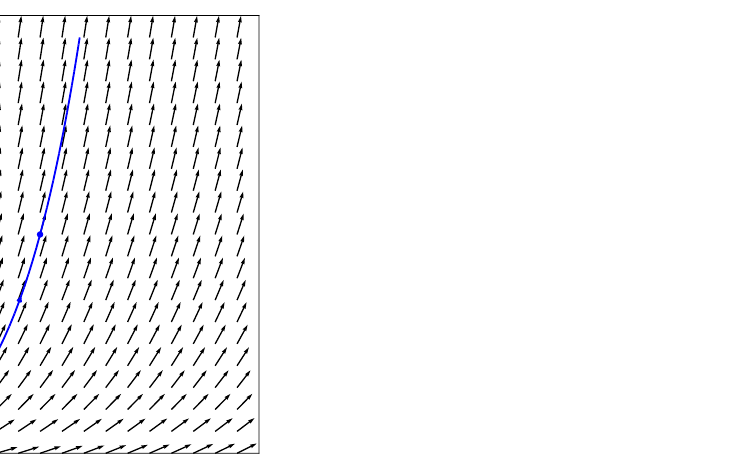
Figure 1. Example of a streamline and its corresponding vector field in 2D. The selected seed point is shown in the center of the